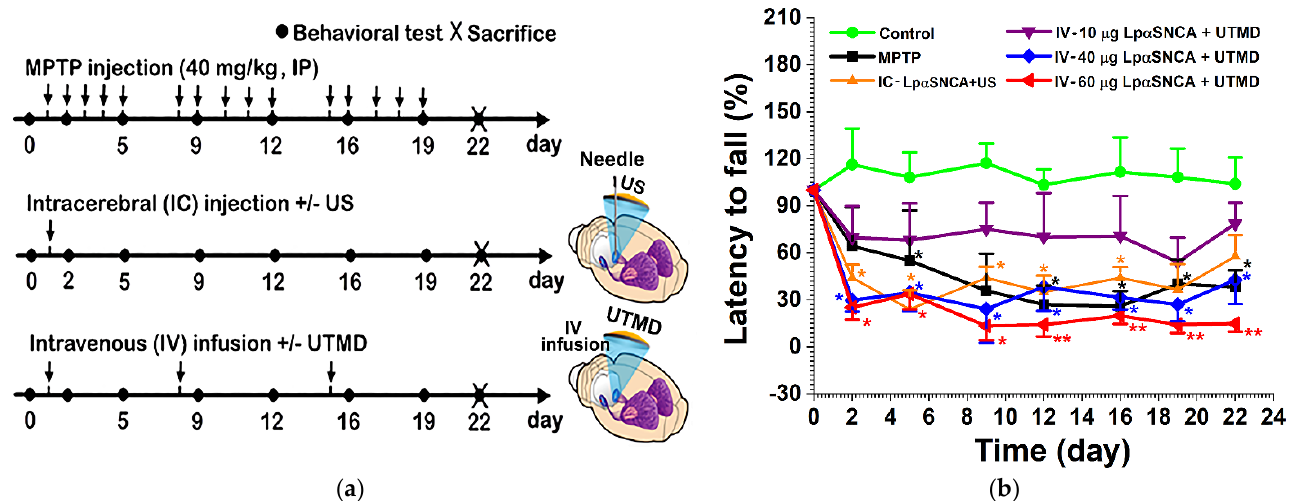
Figure 1. ( a ) Timeline of study design and experimental scheme. Arrows point to when intraperitoneal injections of MPTP (40 mg/kg) were given once a day, 5 days per week for 3 weeks; when single intracerebral (IC) injections of pαSNCA or LpαSNCA +/− US were given; when intravenous (IV) infusions of LpαSNCA +/− UTMD were given; and when animals were scheduled for behavioral testing and sacrificed; ( b ) motor performance of the various groups of mice trained with a rotarod apparatus. Latency to fall for each mouse was recorded on the rotarod performance. Statistical difference was performed with the Mann–Whitney U test; * p < 0.05; ** p < 0.01; n ≥ 5 for each group. MPTP = 1-methyl-4-phenyl-1,2,3,6-tetrahydropyridine; US = focused ultrasound; UTMD = focused